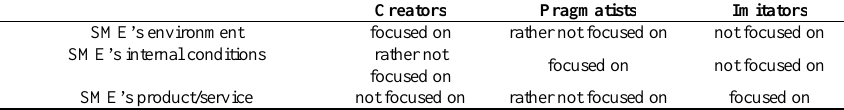
Table 1. Theoretical model of innovation strategies vs. main aspects of enterprise’s functioning Creators focused on rather not focused on not focused on SME’s internal conditions rather not focused on not focused on focused on SME’s product/service not focused on rather not focused on focused on